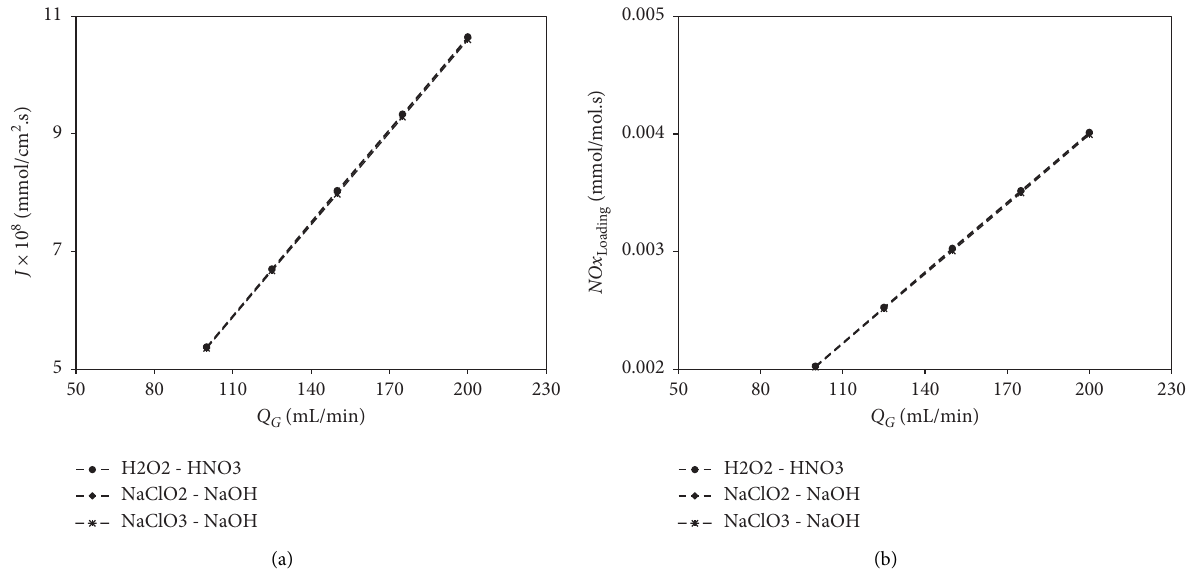
Figure 5: Effect of feed gas flow rate, Q G , on (a) the flux, J ; (b) the NOx loading in a membrane module containing 40 fibers using 400mL of absorbent pairs of H 2 O 2 (0.05 M) - HNO 3 (0.25 M), NaClO 2 (0.05 M) – NaOH (0.25 M), and NaClO 3 (0.05M) – NaOH (0.25